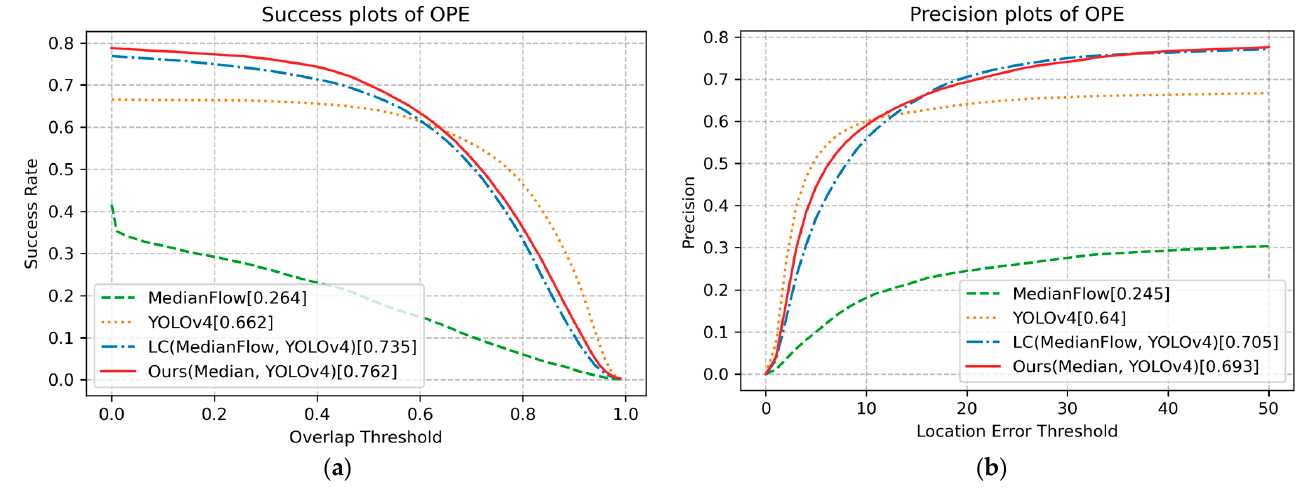
Figure 7. ( a ) Success plots on UAV123 dataset; ( b ) precision plots on UAV123 dataset.